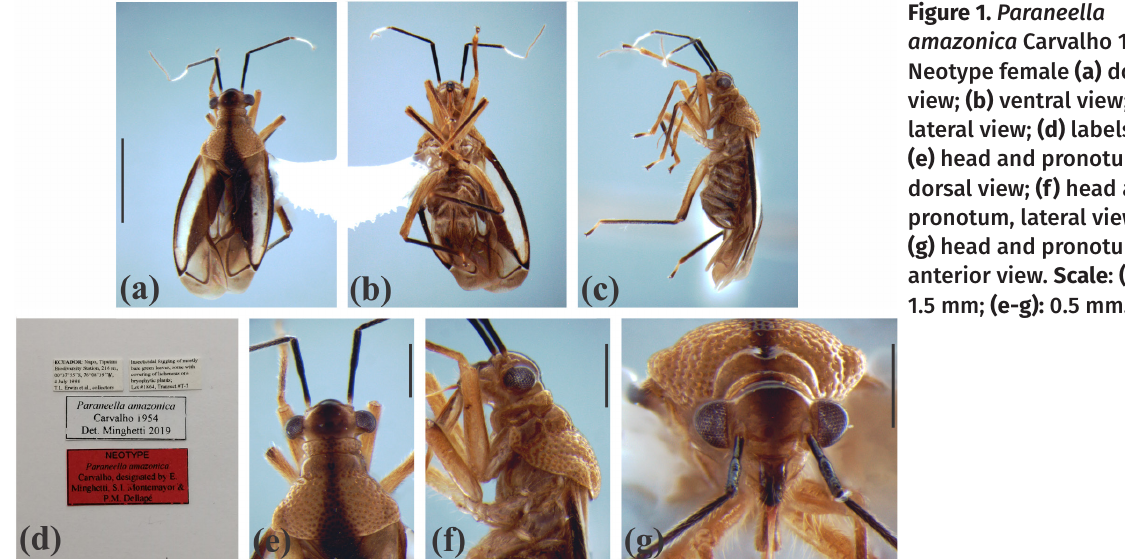
Figure 1. Paraneella Neotype female (a)